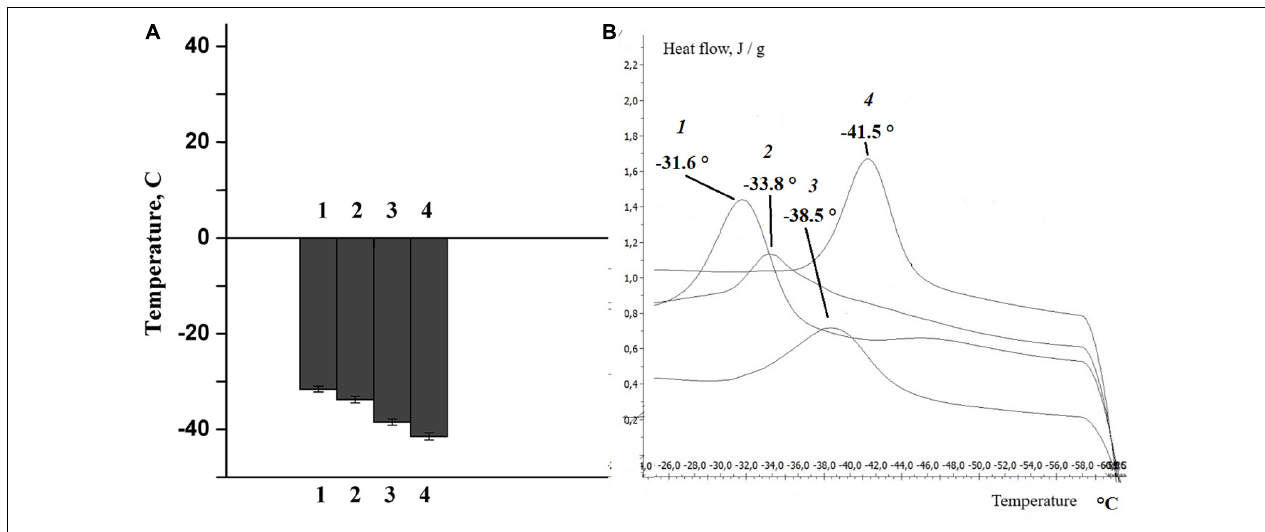
FIGURE 6 | (A) Histogram, (B) differential scanning calorimetry curves of lipids isolated from the sciatic nerve of the rat: control (1), after nerve stimulation (2), after nerve cutting at the proximal site (3), and at the distal site (4).